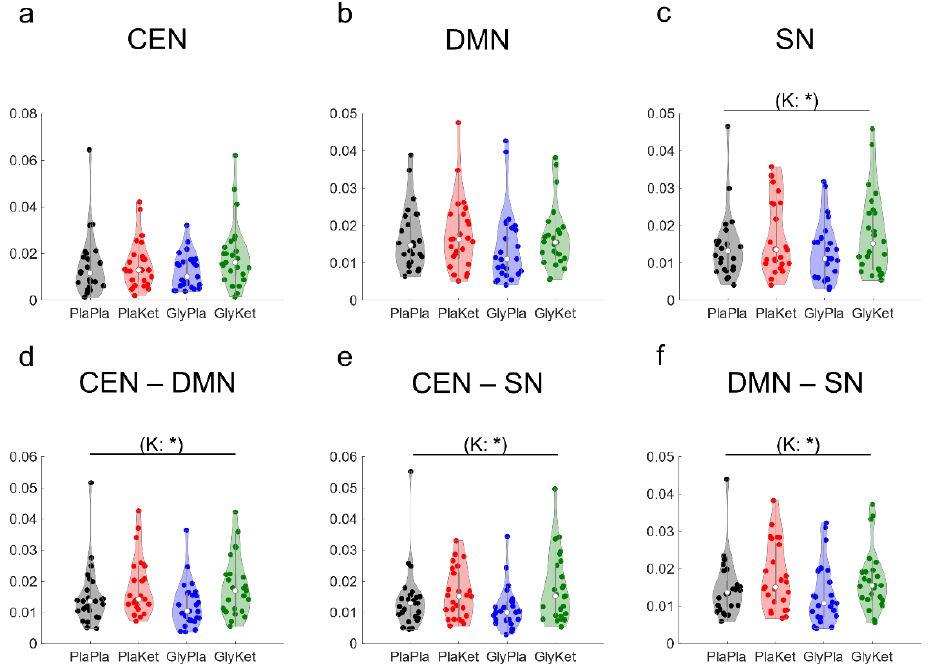
Figure 4. Violin plots of the mean intra-network gamma (30 – 100 Hz) functional connectivity (com- puted as lagged coherence) among all regions of interest (ROI) in the central executive network (CEN; a ), the default mode network (DMN; b ), and the salience network (SN; c ) for all four conditions: the PlaPla (black dots), PlaKet (red dots), GlyPla (blue dots), and GlyKet condition (green dots). Inter-network connectivity is displayed as mean lagged coherence between all ROIs of the CEN and the DMN ( d ), between all ROIs of the CEN and the SN ( e ), and between all ROIs of the DMN and the SN ( f ). (K: ketamine main effect; * p < 0.05; effects that were no longer significant after FDR correction are shown in parentheses).